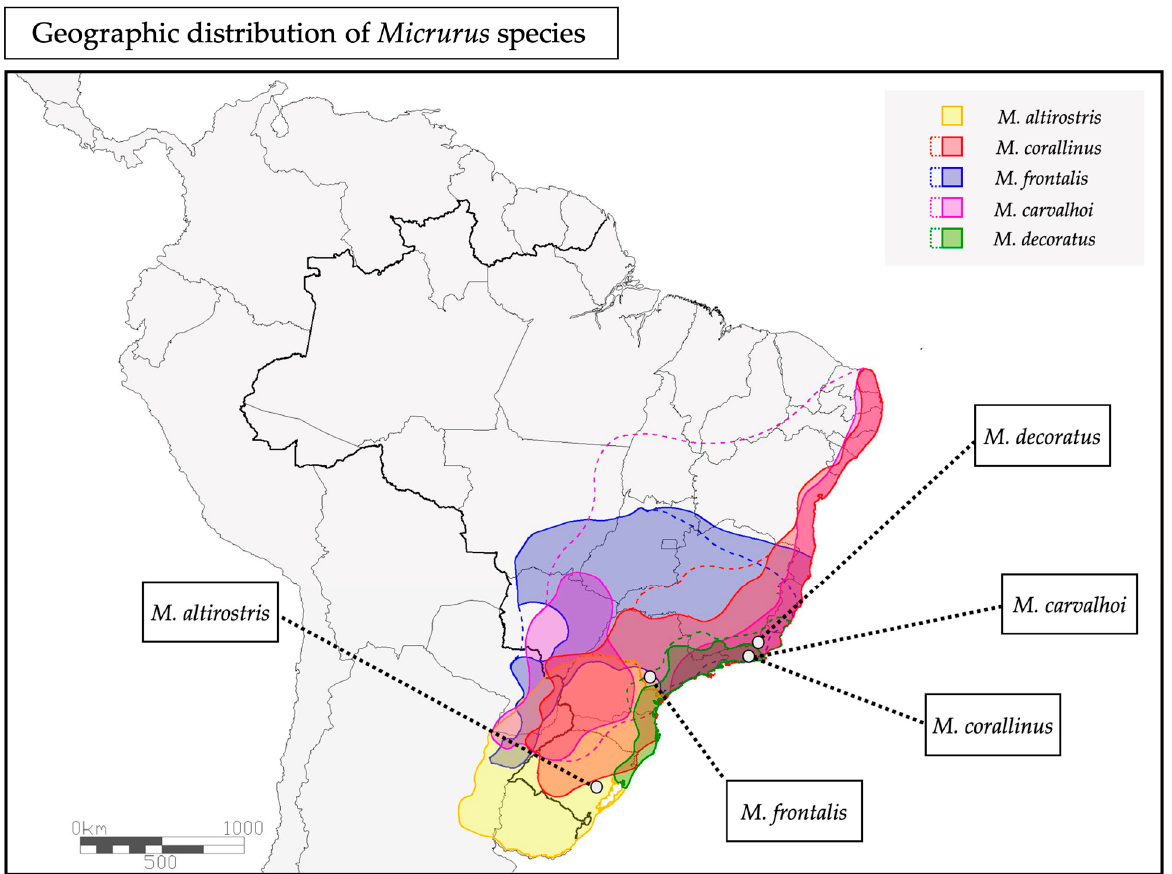
Figure 1. Geographic distribution of the five Micrurus species. The colored areas represent the current consolidated geographic distribution of the Micrurus species, and the dotted colored lines represent the distribution areas under scientific revision. The areas where the specimens used in this work were collected are indicated in the map with the names of the species.